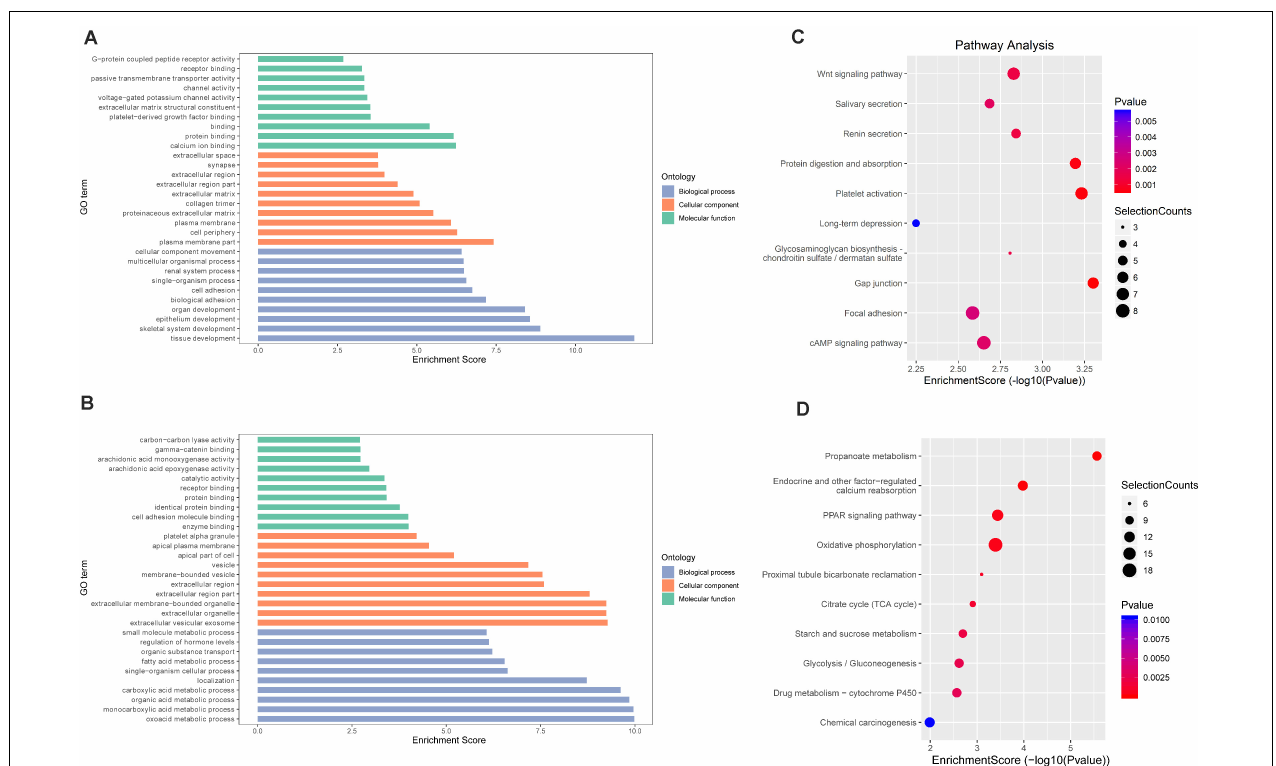
FIGURE 5 | Gene ontology and Kyoto Encyclopedia of Genes and Genomes analyses of coding genes containing DMMSs in TvI. (A) Major gene ontology terms were enriched for the genes containing up-regulated m6A sites in TvI. (B) Major gene ontology terms were enriched for the genes containing down-regulated m6A sites in TvI. (C) Major enriched pathways for the genes containing up-regulated m6A sites in TvI. (D) Major enriched pathways for the genes containing down-regulated m6A sites in TvI.